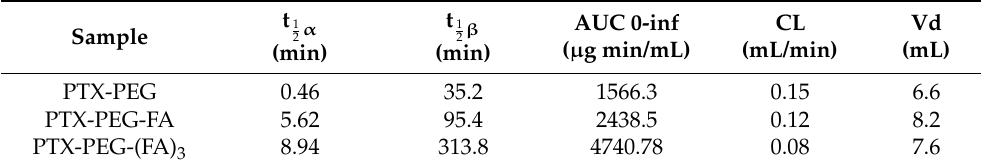
Table 4. Main pharmacokinetic parameters of PTX-PEG-FA and PTX-PEG-(FA) 3 after IV administra- tion of 10 mg/kg (PTX equiv.) in Balb/C